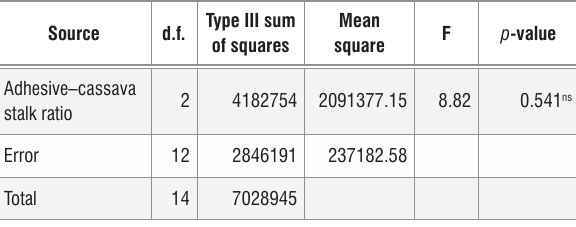
Table 5: Analysis of variance of the effect of materials variables on modulus of elasticity Type III sum Source d.f. of